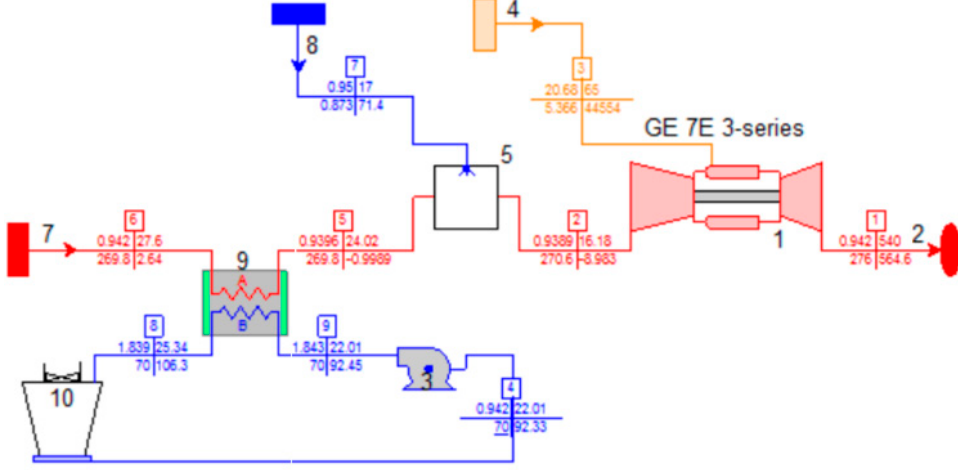
Figure 8. Gas turbine with two-stage evaporative inlet cooling.